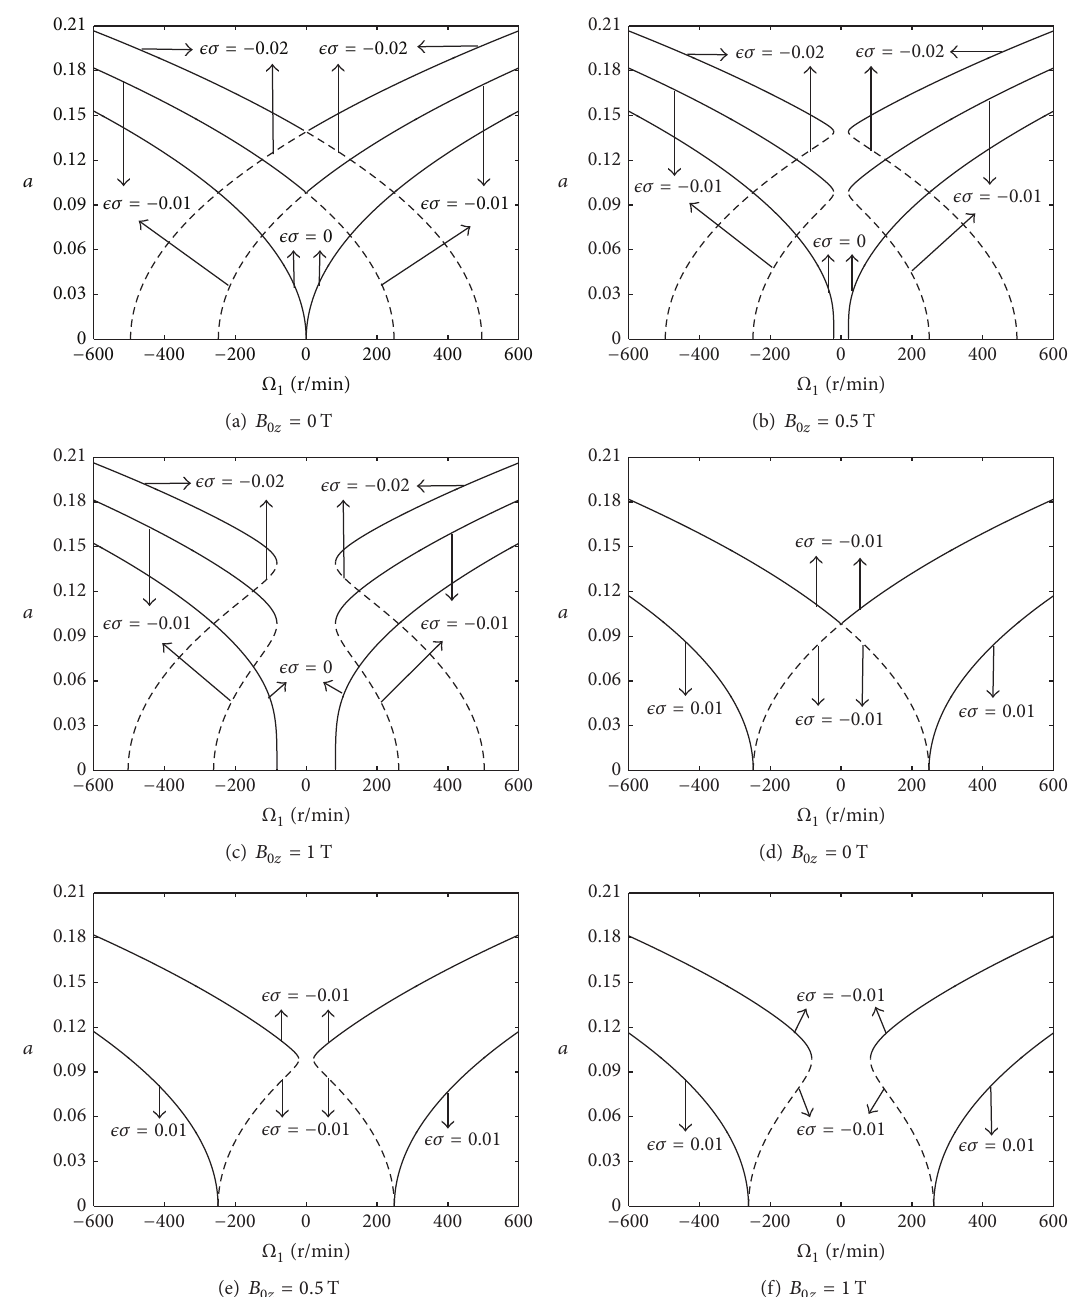
Figure 7: The characteristic curves of resonance amplitude-amplitude of velocity disturbance term.